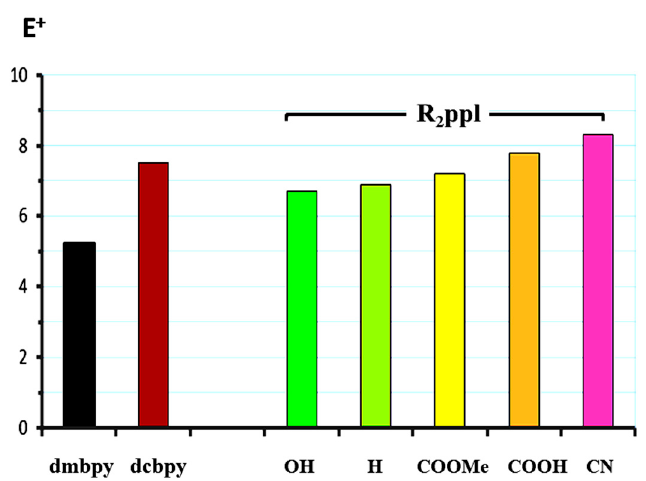
Figure 16. Electrophilicity index for R 2 ppl ligands.